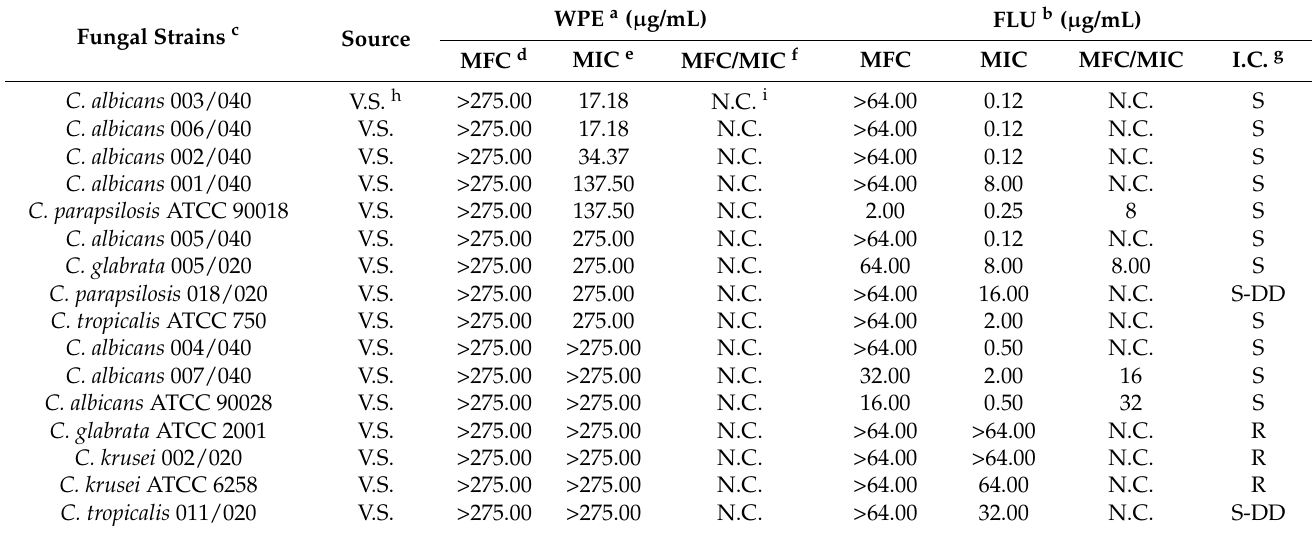
Table 3. Antifungal activity of walnut pellicle extract.